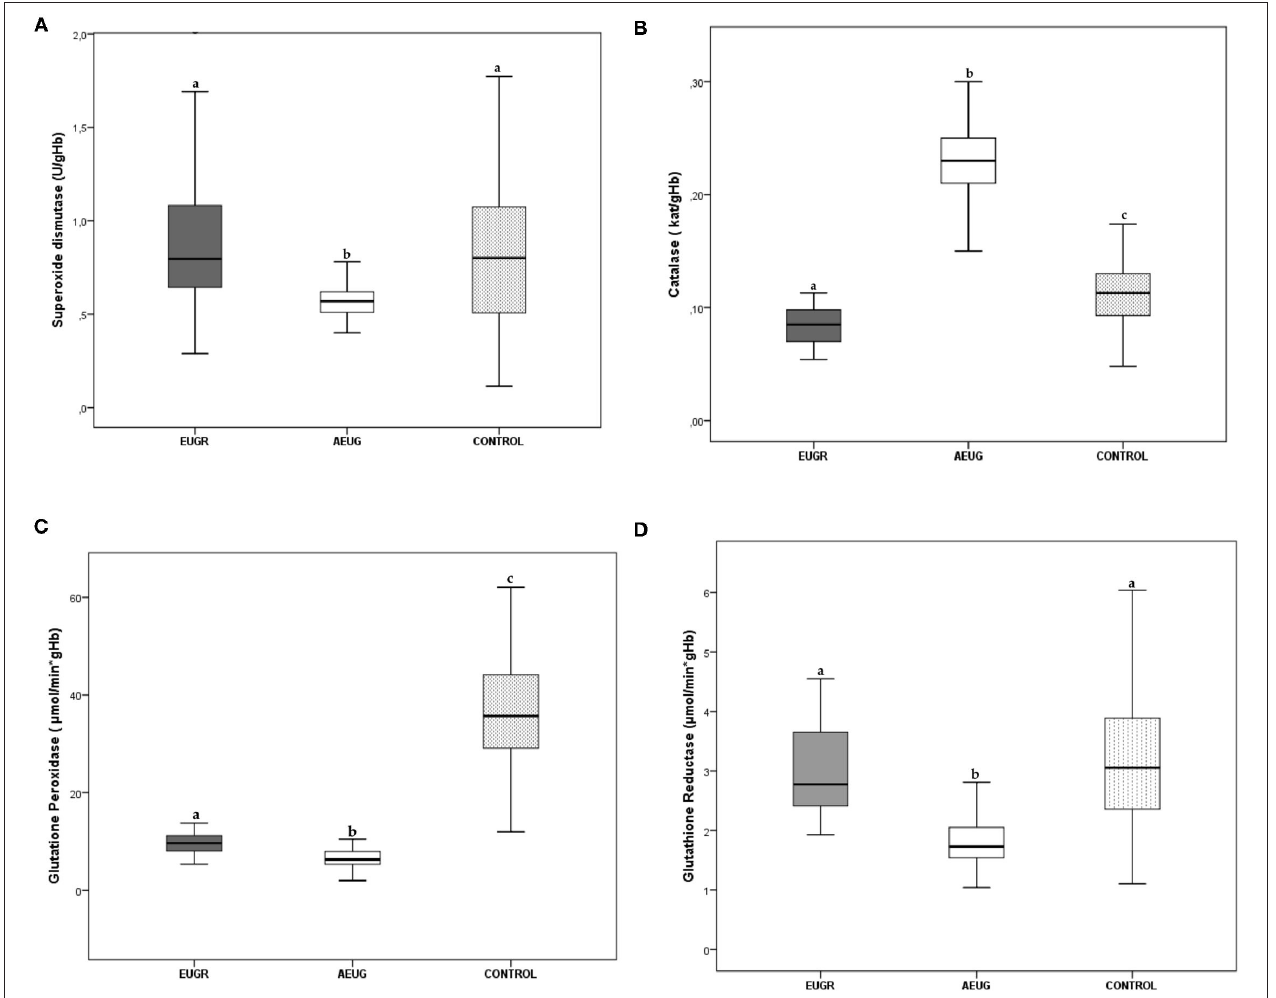
FIGURE 1 | Erythrocyte superoxide dismutase (A) , catalase (B) , glutathione peroxidase (C) and glutathione reductase (D) activities in prepubertal children with a history of prematurity and EUGR ( n = 38), premature with adequate extrauterine growth (AEUG) ( n = 50) and control children ( n = 123). Values are expressed as medians and interquartile ranges for the rest of the enzymes. a,b,c Values within a row with unlike superscript letters were significantly different ( < 0.001). (Kruskal–Wallis and Mann–Whitney U tests). P -value indicates probability adjusted for age, sex, gestational age, birth weight and prepubertal